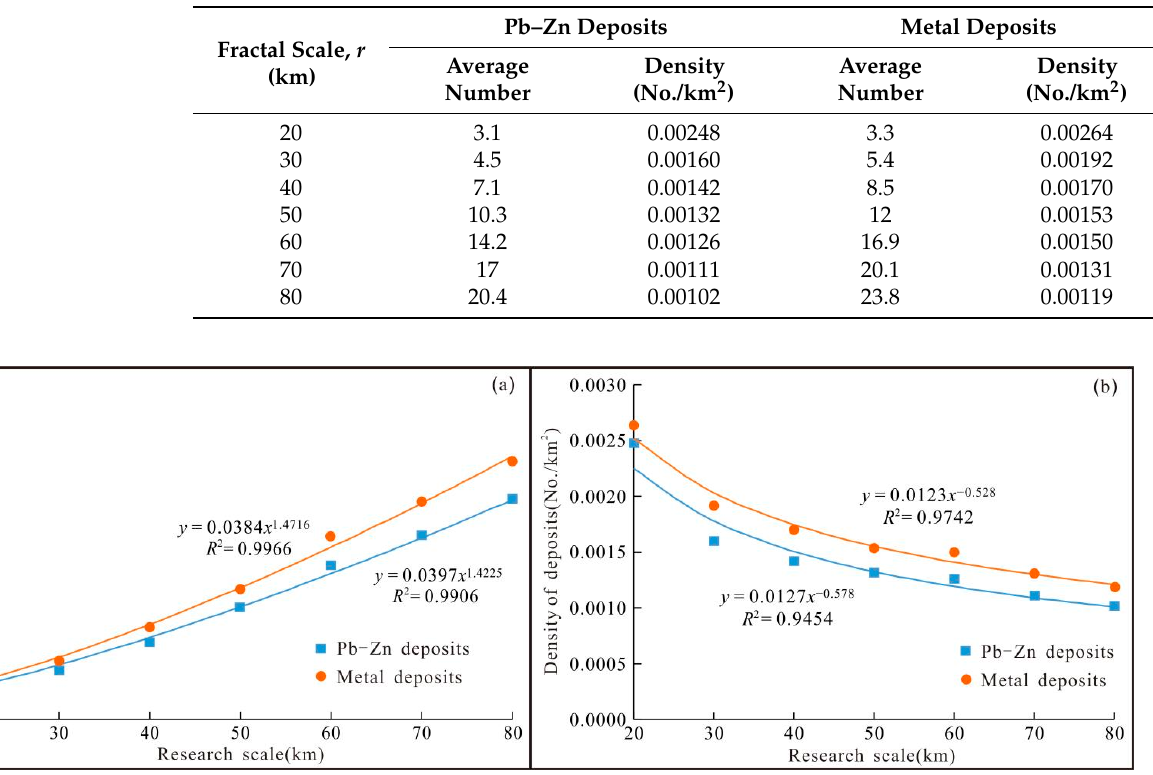
Figure 8. Fitting diagram of fractal distribution for deposit number ( a ) and density ( b ). Table 11. Statistics of fractal distribution data of deposit number and density.